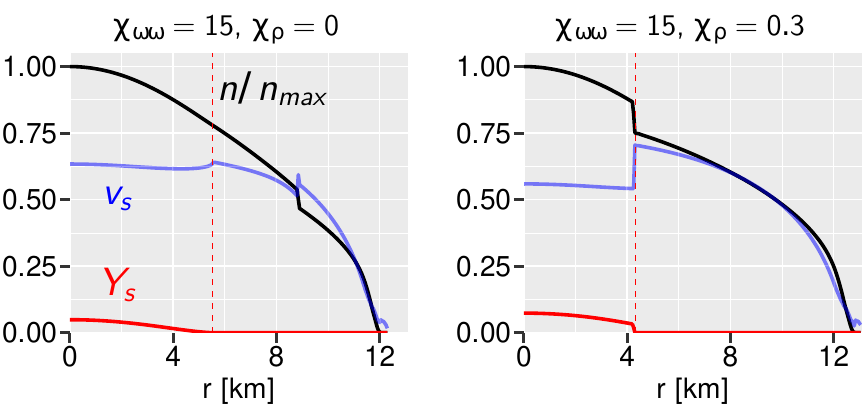
Figure 3. NS profile: the normalized baryonic density ( n / n max ), sound velocity ( v s [c]), and strangeness fraction ( Y s ) as a function of the radius for a 1 . 9 M (cid:3) hybrid star.